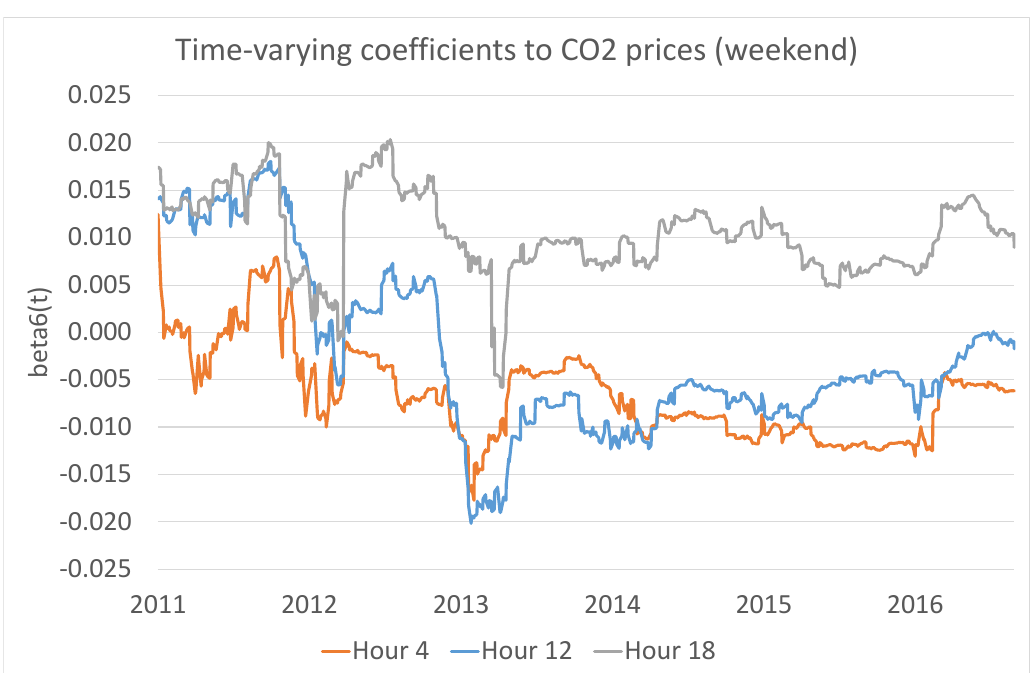
Figure 11. Time-varying coefficients of coal and CO 2 prices. The coefficients have been estimated for the sample period from 1 January 2011 until 31 August 2016 with respect to the key hours H4, H12 and H18 on weekend